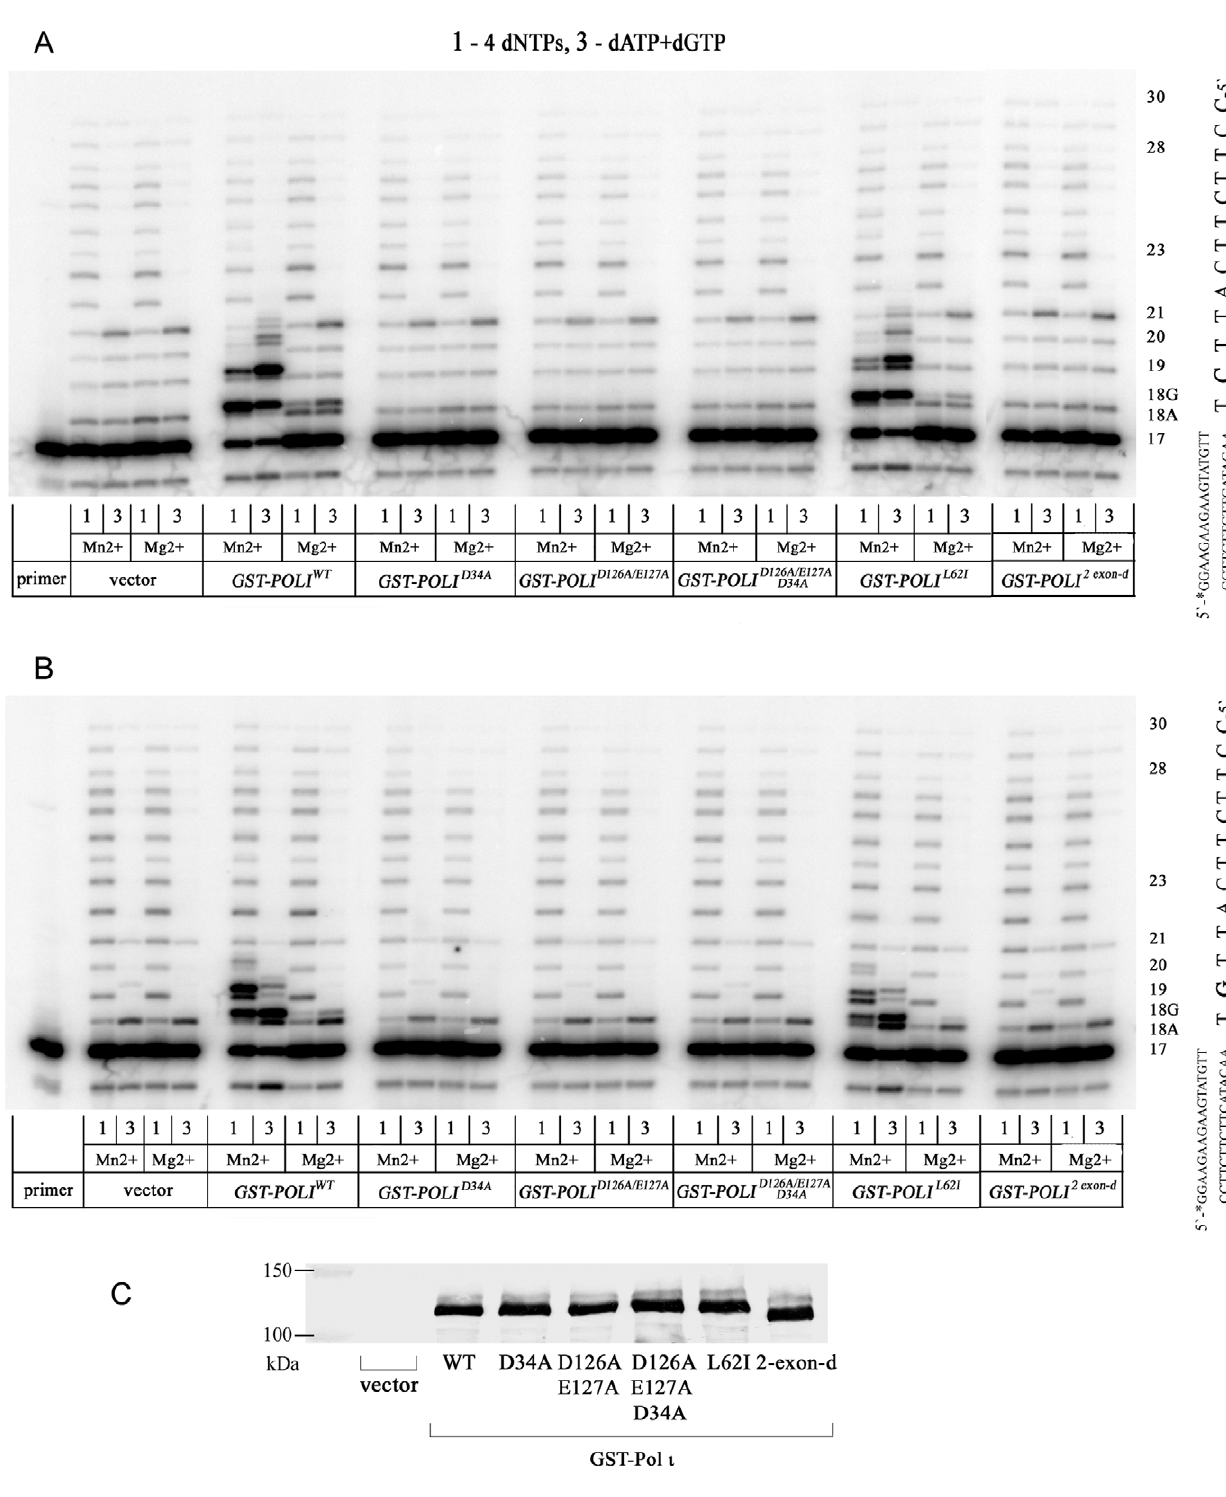
Figure 3. misGvA by yeast extracts producing variants of Pol i . A. misGvA activity of cell extracts of yeasts producing GST-Pol i variants was estimated by ‘‘misGvA’’ in 8-min reactions in the presence of 0.15 mM Mn 2 + and 0.25 mM Mg 2 + divalent metal ions at template 1 as described in ‘‘Materials and Methods.’’ Two combinations of equal concentrations of 1 mM dNTPs have been used: 1) all dNTPs and 2) dGTP and dATP. B. Same with template 2. B. Western-blot analysis of the production of GST-tagged Pol i catalytically compromised variants in yeast cells extracts. Extracts containing 40 m g of total protein were separated on 8% polyacrylamide-SDS gel, transferred to a PVDF membrane and probed with polyclonal anti- GST antibodies. Cross-reacting proteins were visualized according to the Western Breeze Chromogenic Anti-Rabbit Kit procedure (Invitrogen).